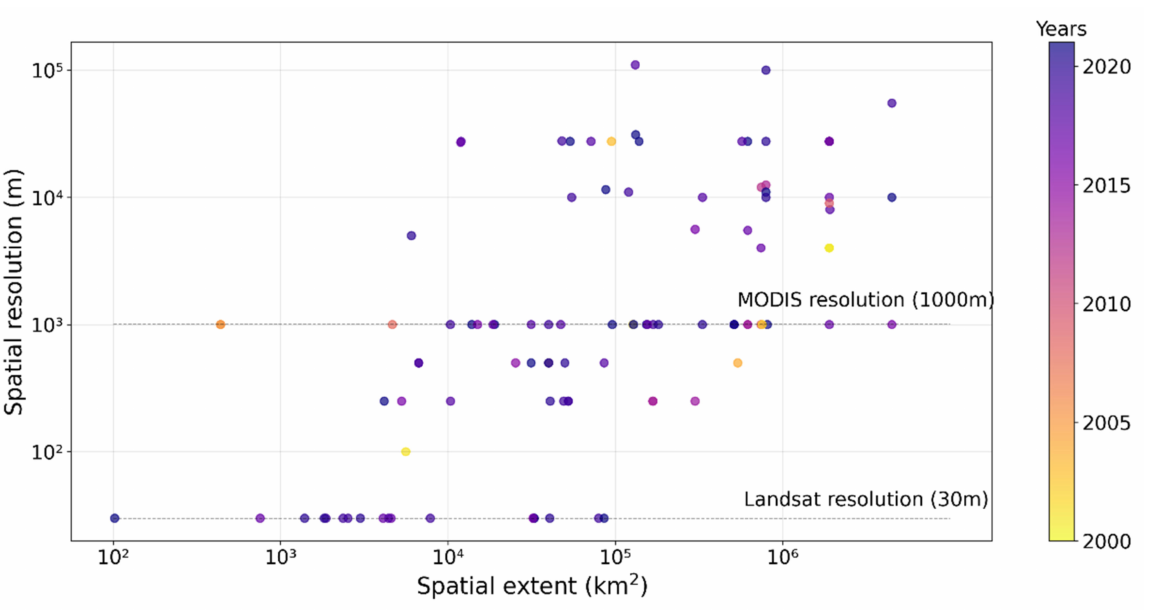
Figure 8. The relationship between the spatial extent and mapping resolution among all of the drought remote sensing articles in Southeast Asia from 2000 to 2021. The color bar represents the years of